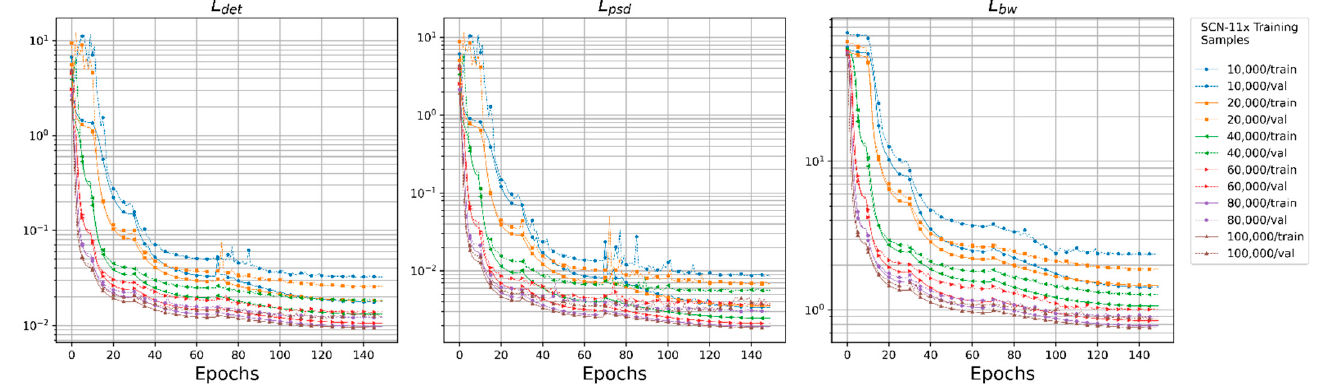
Figure 7. The training and validation loss of the SCN-11x trained with different numbers of simulation samples, where L det is the total loss, L psd is the PSD regression loss, and L bw is the BW regression loss.